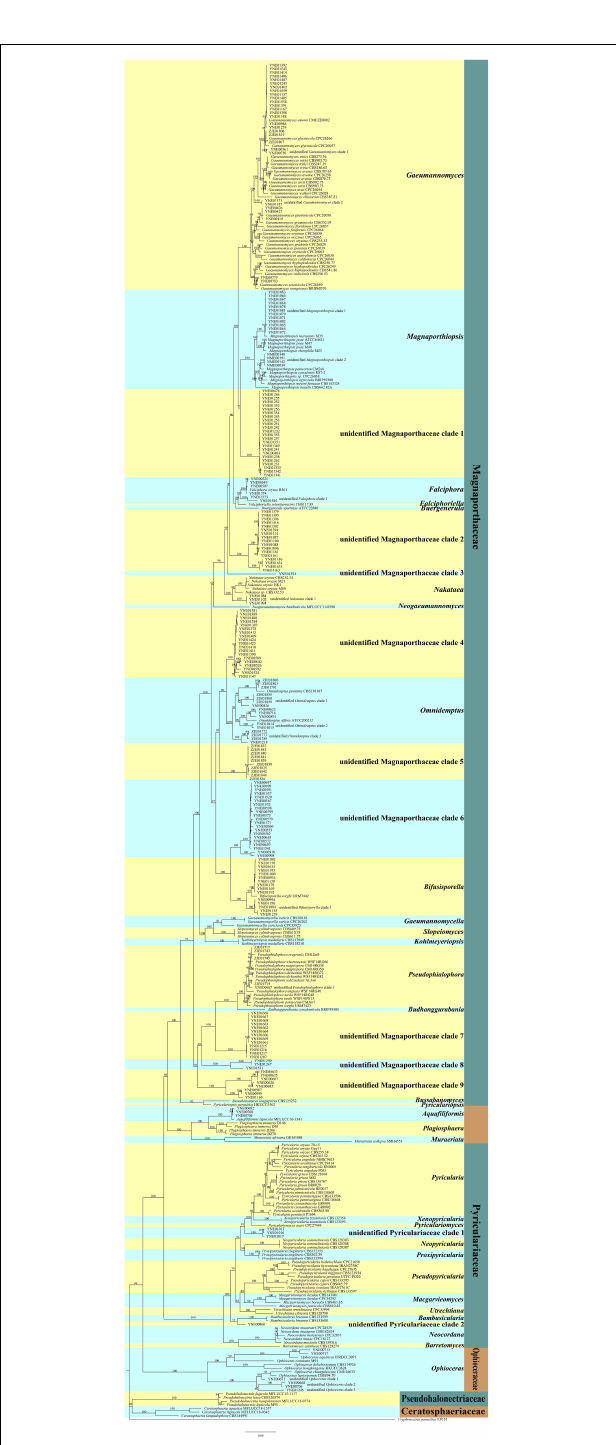
FIGURE 1 | Multi-loci phylogenetic tree based on ITS, LSU, MCM7 , RPB1 , and TEF1 using maximum likelihood (ML).